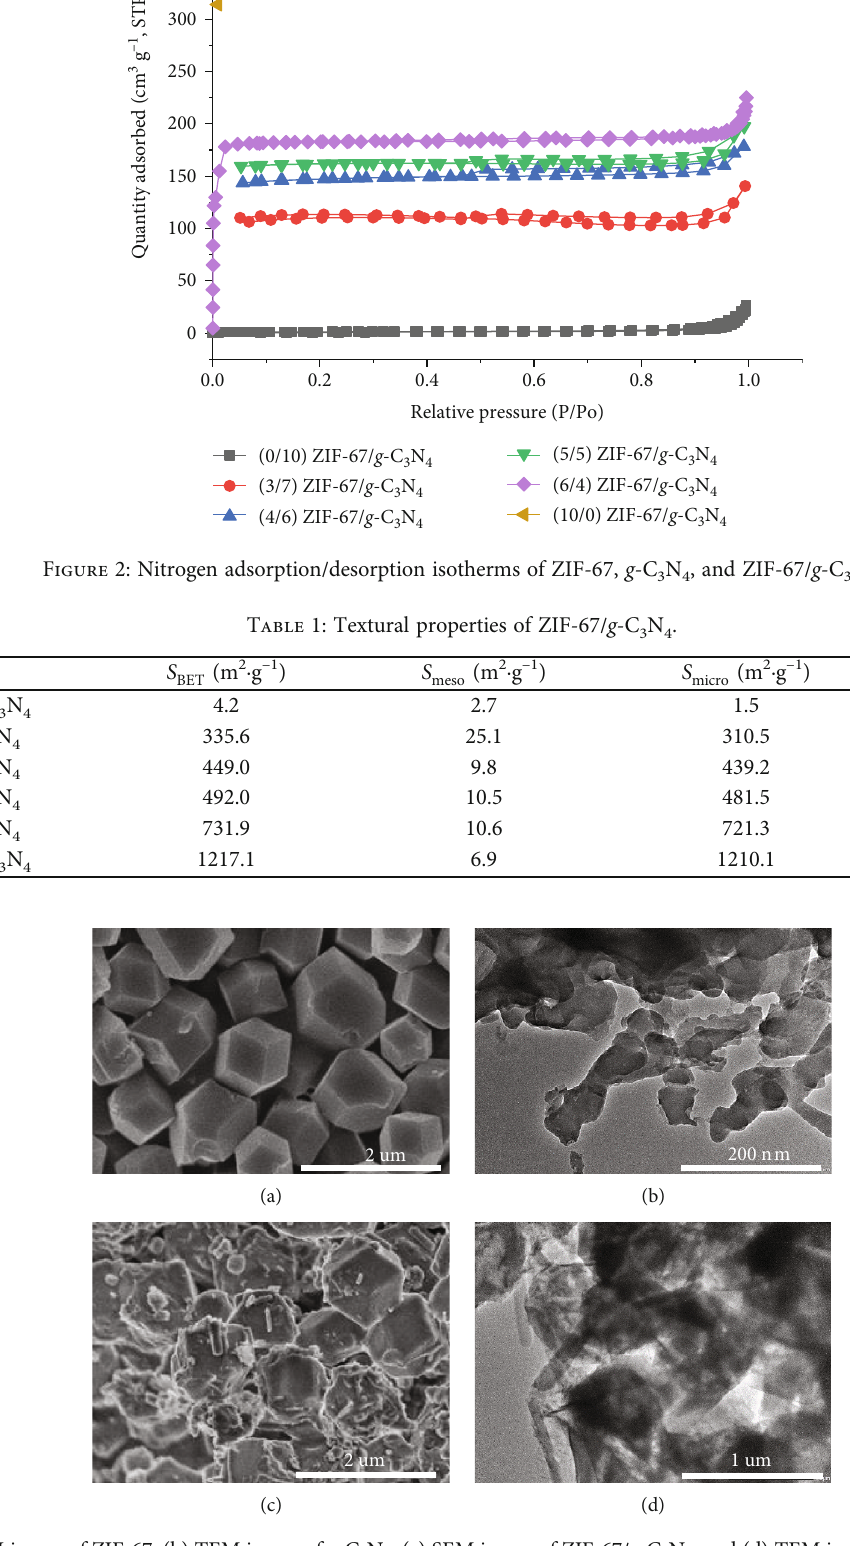
N , (c) SEM image of ZIF-67/ g -C 3 4